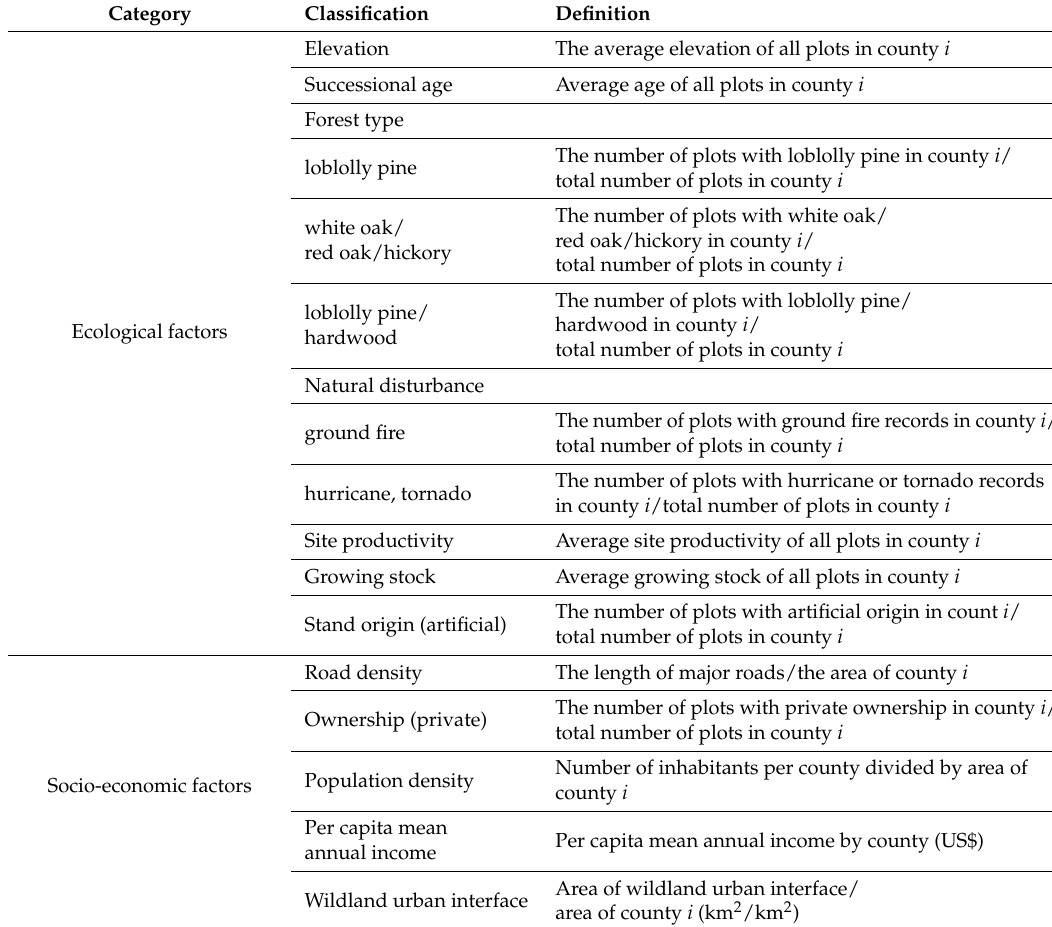
Table 2. Definition of ecological and socioeconomic factors contributing to the presence and abundance of target invasive tree species in Mississippi at the county